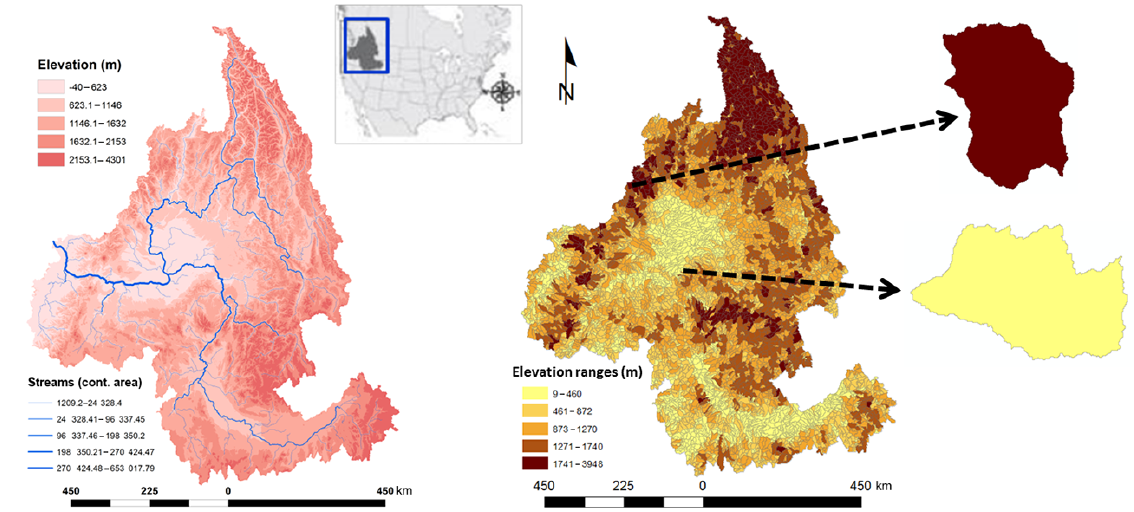
Figure 1. The topographic distribution (left) and subbasin delineation (right) of the study area (Columbia River basin). Two subbasins selected to represent the extreme classes of elevation ranges are shown on the far